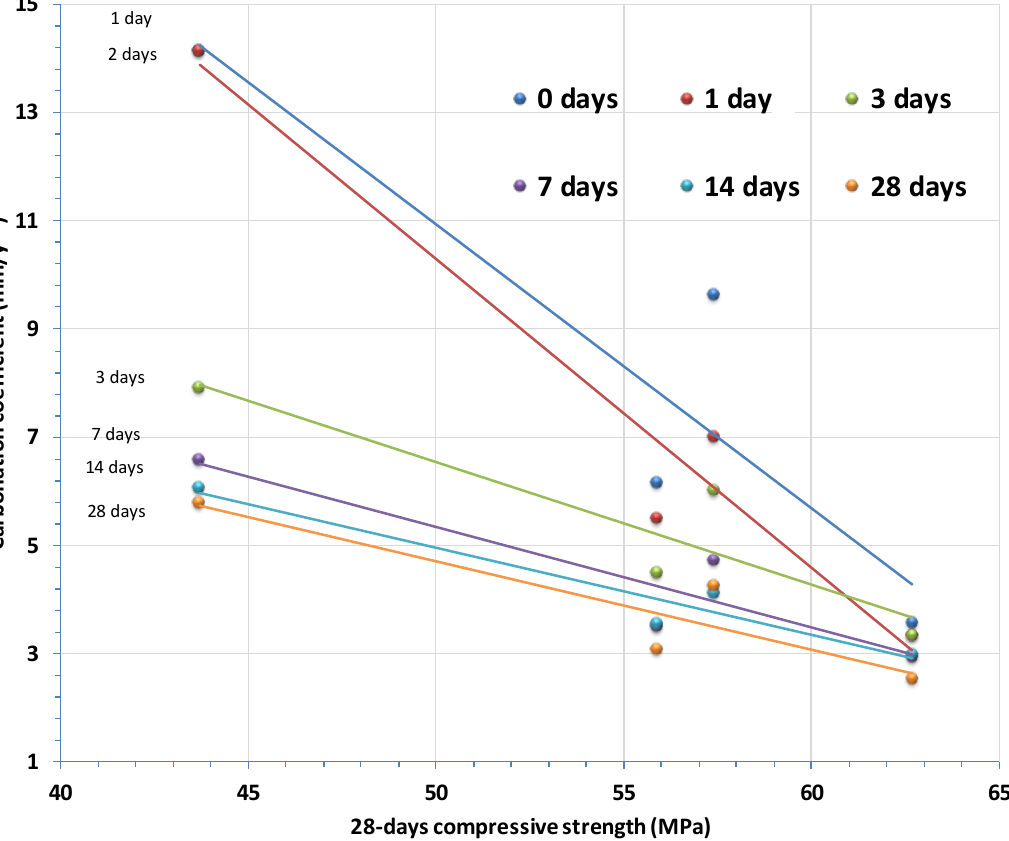
Figure 4. Carbonation coefficient versus 28-day compressive strength relationship of mortars made with ground granulated blast-furnace slag and cured underwater for 0, 1, 3, 7, 14, or 28 days.